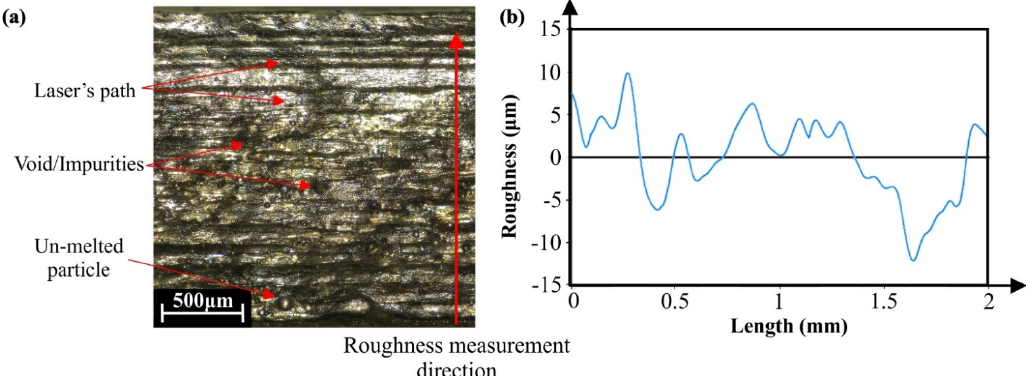
Figure 4. Indicatives: ( a ) Multi-focus image and ( b ) roughness profile of the P8